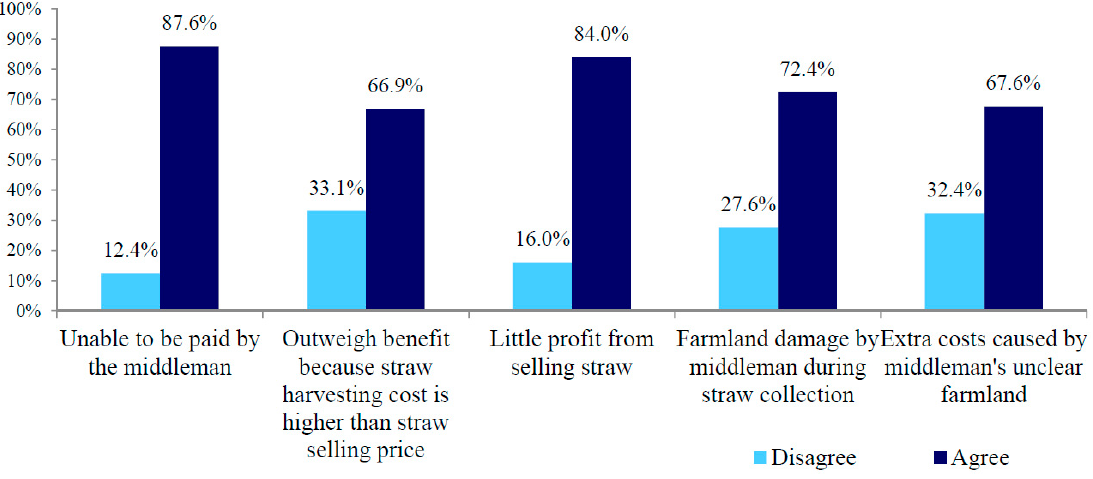
Figure 2. Perceived risks in relation to the selling of crop straw.